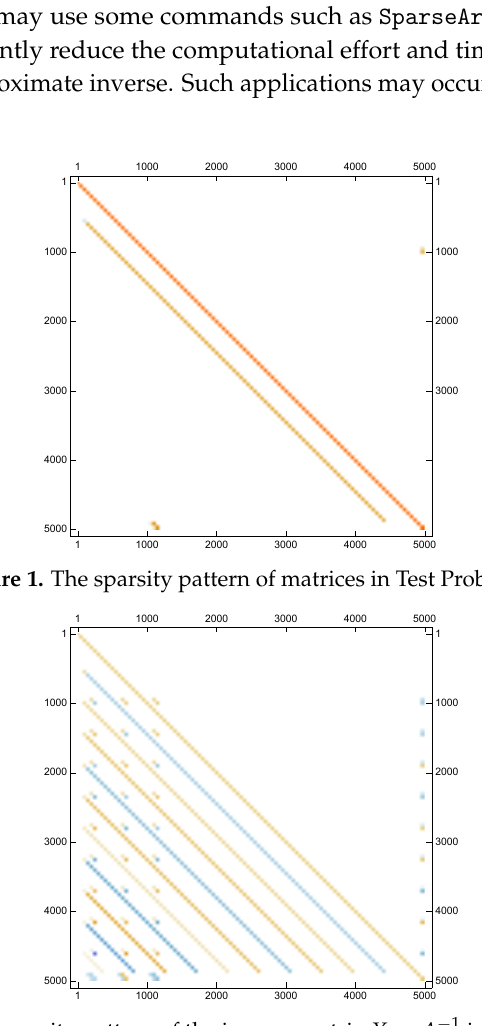
in Test Problem 25